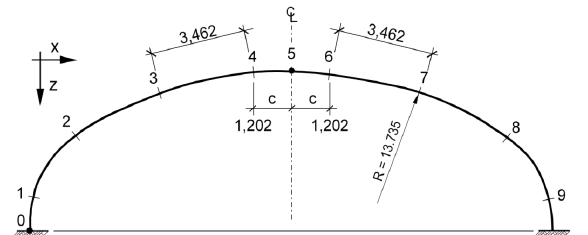
Figure 7: Arrangement of measuring points in perimeter zone of shell in Rydzyna.